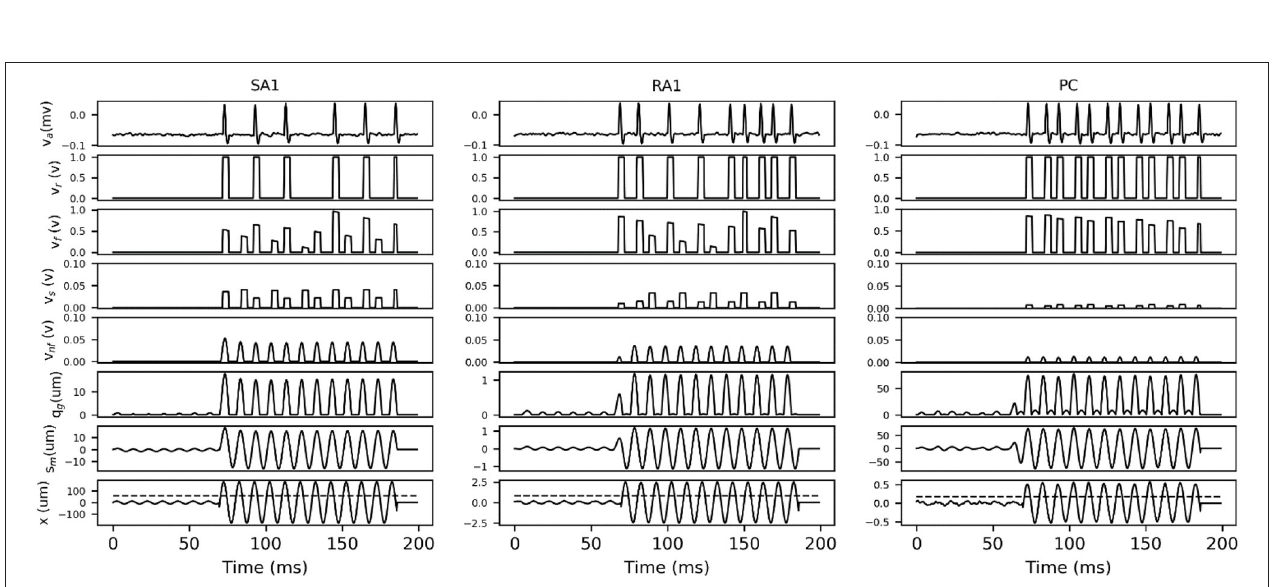
FIGURE 2 | (A) Averaged loss value ( J ( θ ) ) changing with iterations under different highest order of BPF (n). (B) Fitting precision changes with highest order of BPF. Error bars represent the standard deviation. The difference between the fitting precisions at two orders was evaluated using post-hoc tests.